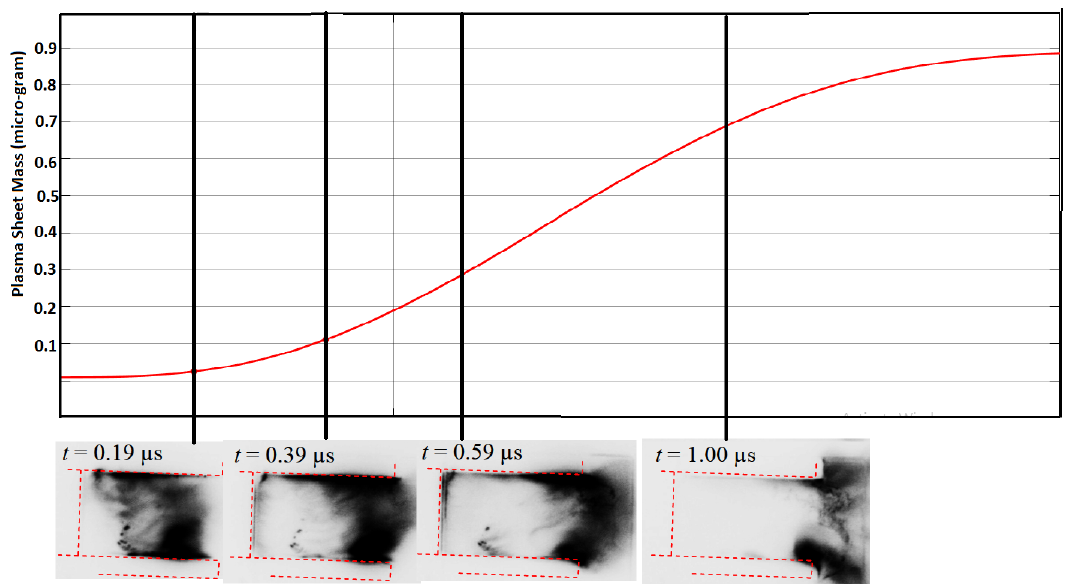
Figure 9. Comparison of the numerical simulation for plasma mass with the high speed photographs [27].